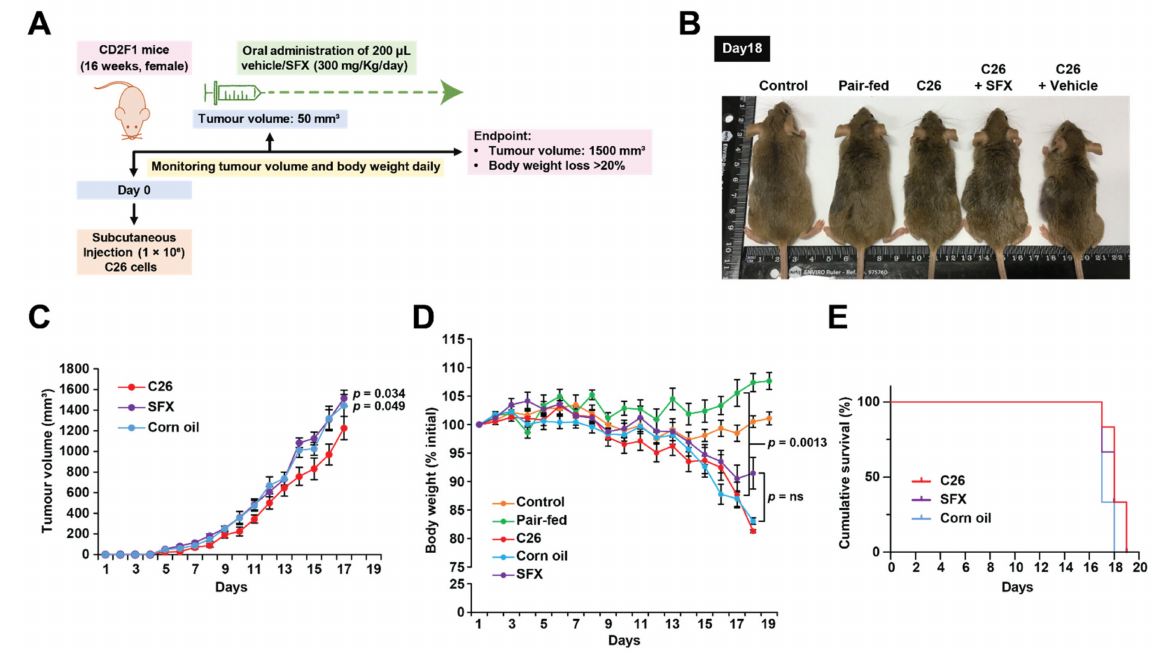
Figure 1. SFX partially inhibits cancer-induced weight loss in C26 tumour-bearing mice. ( A ) Schematic representation of the in vivo study. Female CD2F1 mice (16 weeks old) were injected subcutaneously with C26 (1 × 10 6 ) in the upper left flank region. At 50 mm 3 of tumour volume, a single dose of SFX suspended in 200 µ L of corn oil at a concentration of 300 mg/Kg per day was orally gavaged. Tumour volume and body weight were monitored daily, and mice were sacrificed when body weight loss was ≥ 20% or when tumour volume reached ≥ 1500 mm 3 . ( B ) Representative image of the C26 bearers with SFX treatment and vehicle control upon scientific endpoint (day 18). C26 bearers and vehicle control lost ≥ 20% of the body weight when compared to the pair-fed and control groups. ( C ) Tumour volume was measured at the indicated time points. ( D ) Group average body weight standardised to starting weight ± SEM of 16 weeks, female CD2F1 mice. ( E ) Kaplan–Meier curve showing SFX treatment did not improve the survival of mice. All data are representing mean ± SEM, NS (not significant) unpaired two-tailed Student’s t -test ( n = 6 mice per